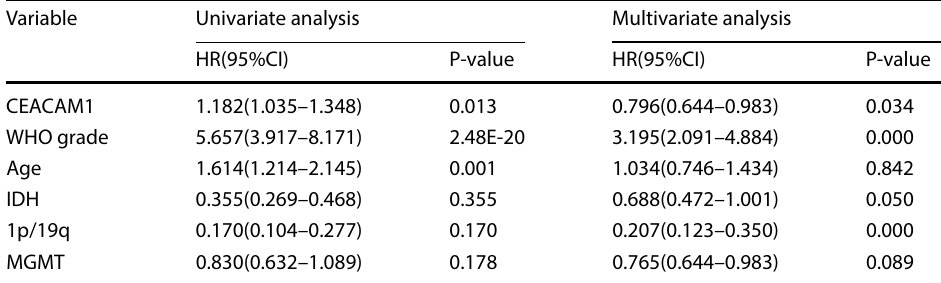
Table 2 Univariate and multivariate analysis of prognostic parameters in the Chinese Glioma Genome Atlas (CGGA) database overall survival (OS)